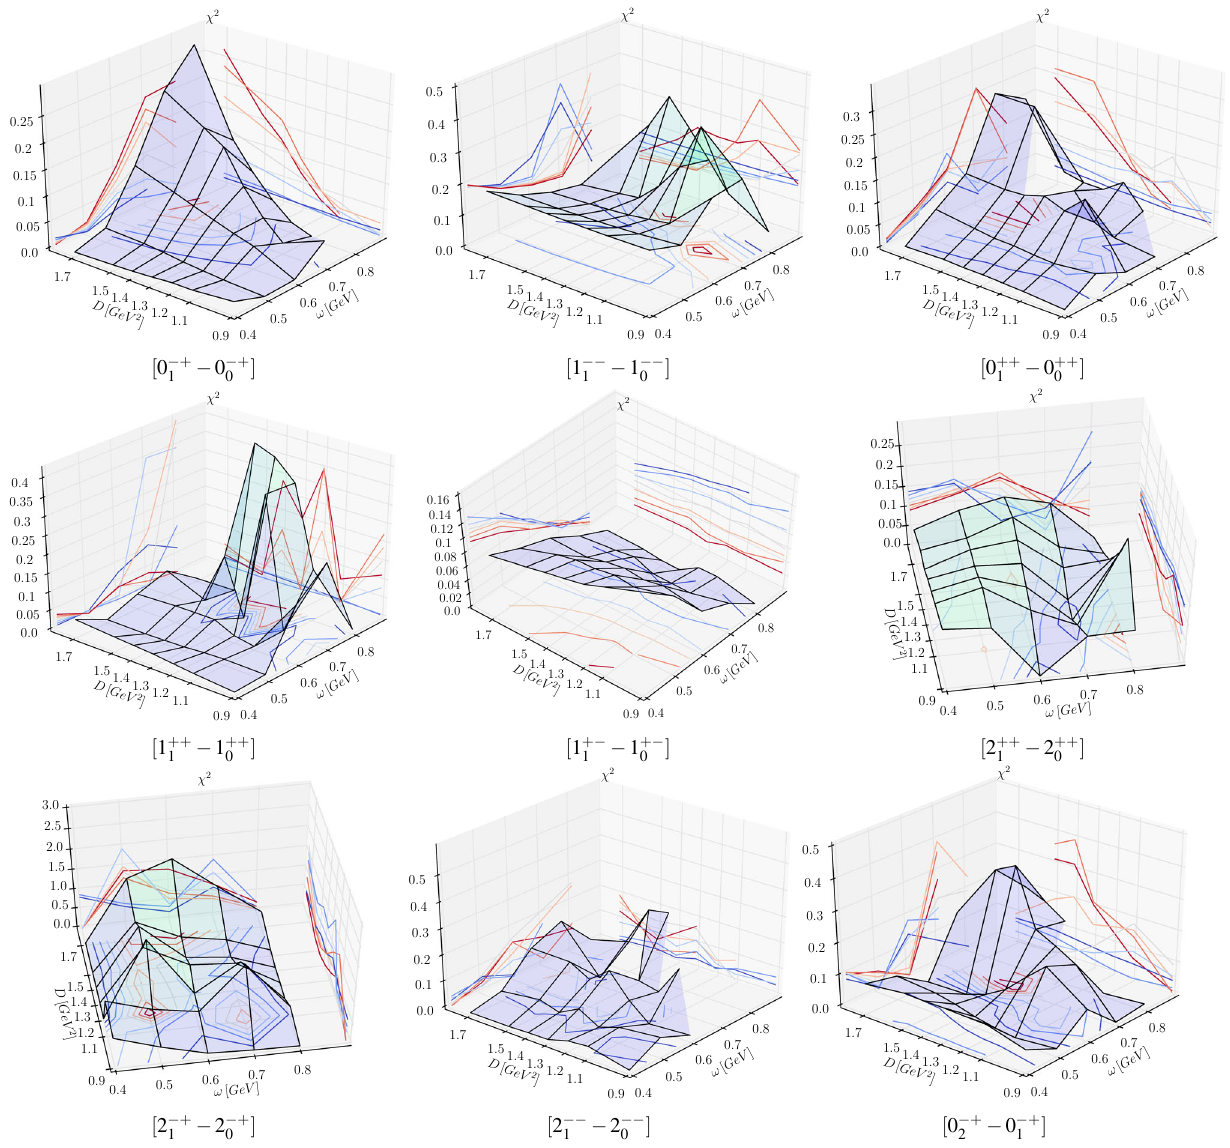
Fig. 16 χ 2 plot from the comparison of our calculated and the experimental radial splitting as a function of ω and